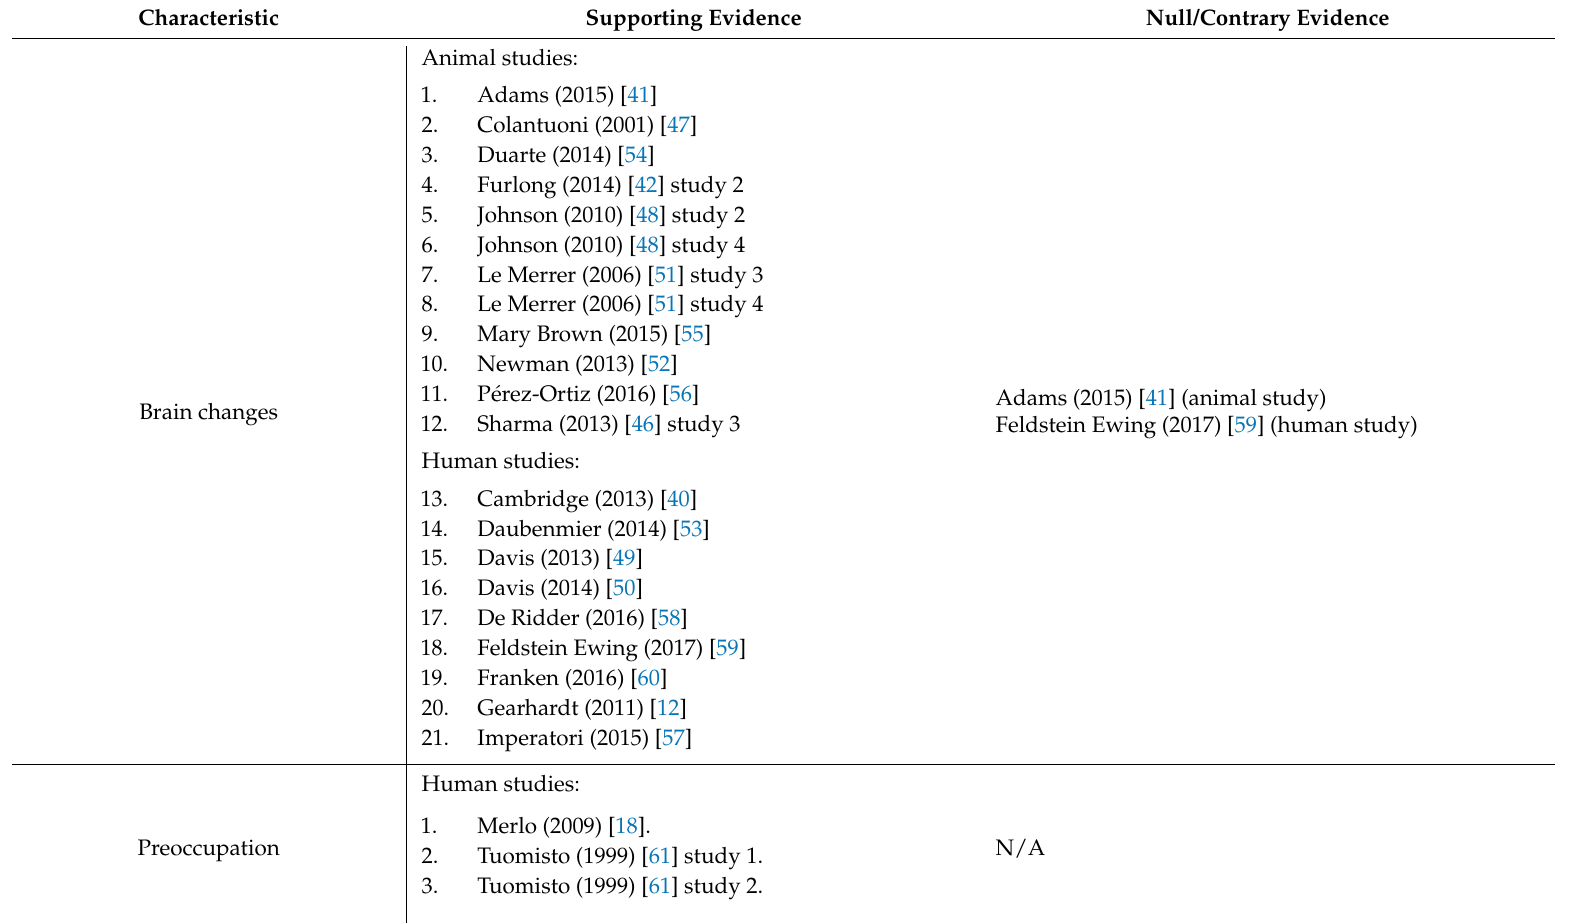
Table A3. Evidence for and against addiction